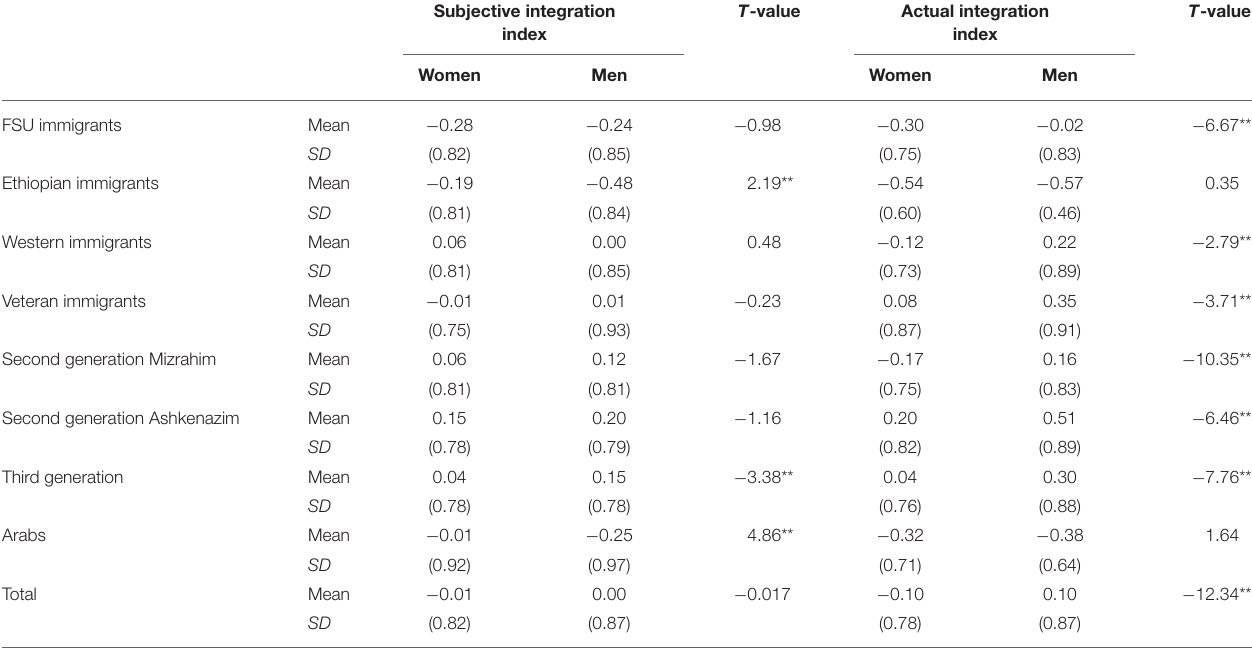
TABLE 2 | Descriptive statistics of subjective and actual integration in the labor market by ethnicity and